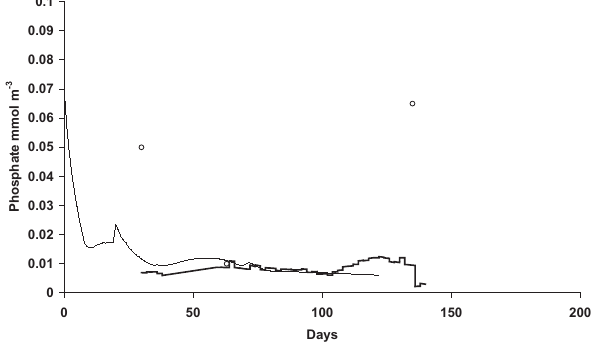
Fig. 8. EnKF solution ( ) with chlorophyll-a assimilated every two days and the reference solution ( ) for phosphate at 65m at the M3A site, along with in situ data ( ◦